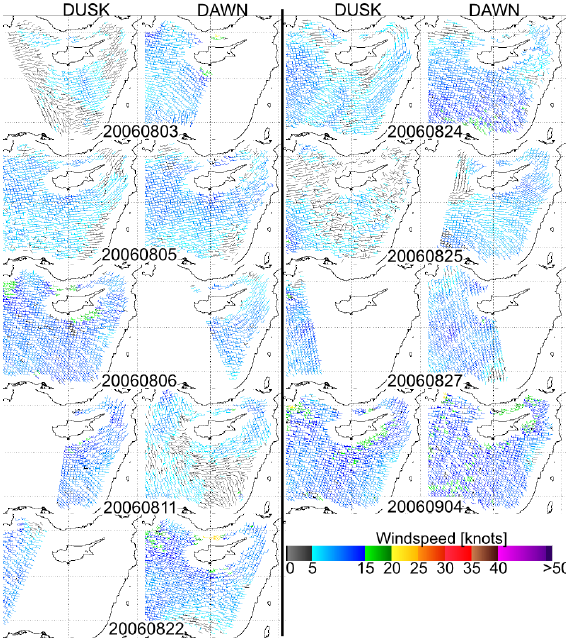
Figure 4. Quickscat wind measurements. The direction of the barbs indicate the wind direction while their color provide the windspeed information. The black barbs mark unreliable data due to rain. Quickscat visits the same area twice a day, at dusk and dawn. Using the method described in Section 2, and the data presented in Figures 3 and 4, results were obtained for the Jiyeh oil spill. The results are presented in Figures 5 and 6.